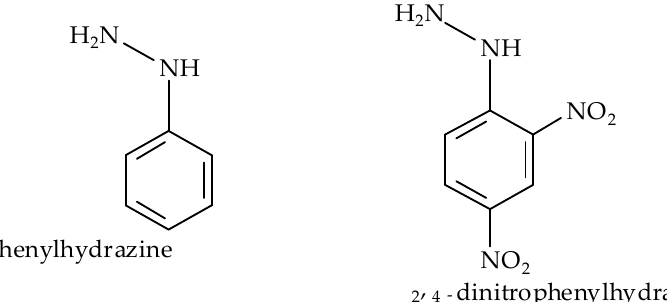
Figure 1. Phenylhydrazine derivatives.